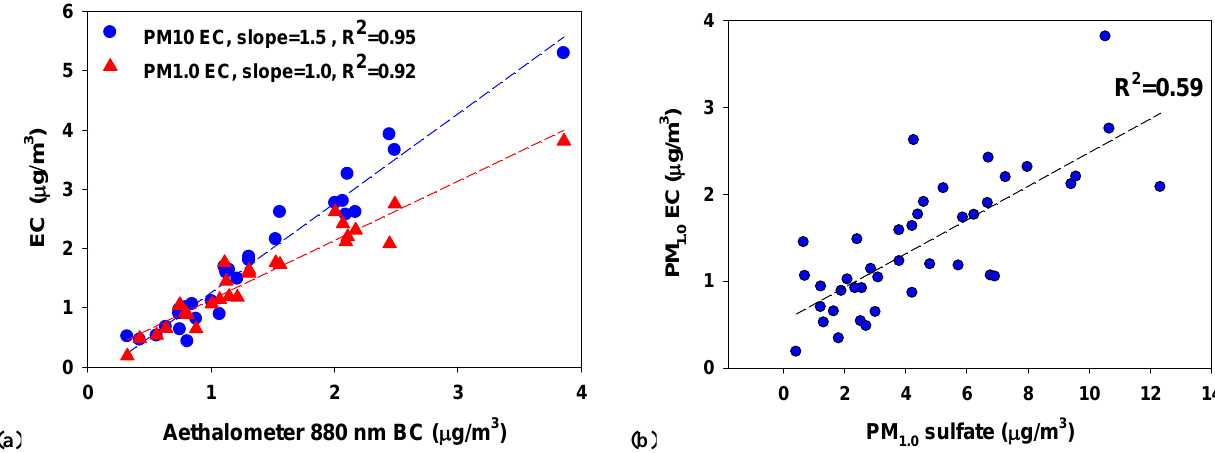
Fig. 6. Correlations of (a) BC measured by Aethalometer at 880nm with EC in PM 1 . 0 and PM 10 and (b) sulfate with EC in PM 1 . 0 . The Aethalometer acquires data at seven wavelengths from the ultraviolet to near-infrared: 370, 470, 520, 590, 660, 880, and 950nm. BC concentrations were averaged for 24h in accordance with collection duration for filter samples. The dotted lines represent linear regression fits, for which R 2 values are given.